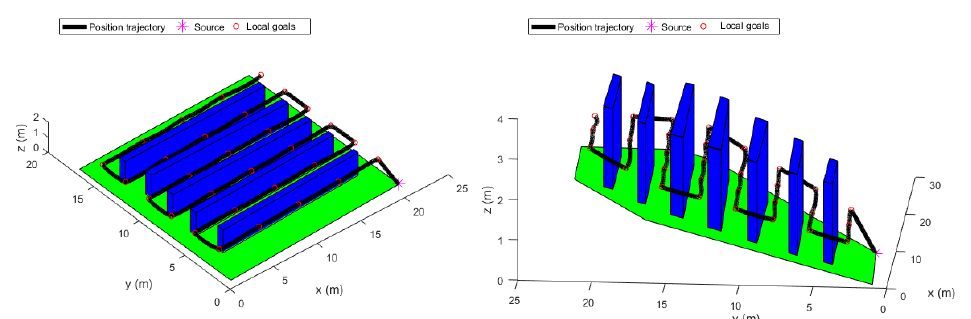
Figure 11. The generated optimal trajectories (3D View).